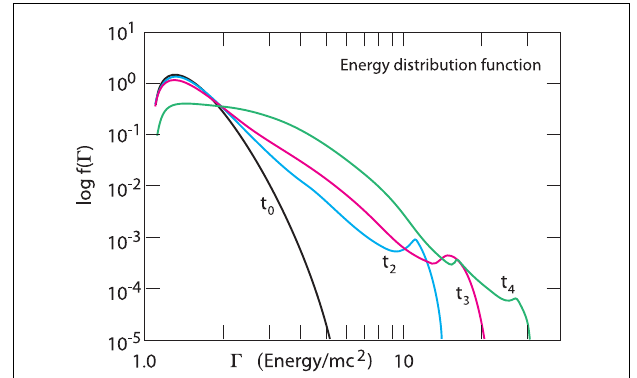
FIGURE 15 | Evolution of a high energy tail on the initial particle distribution function in pair plasma simulations of three-dimensional reconnection [schematized, simulation data after 42]. Three of four equally space consecutive simulation time snapshots of the relativistic distribution function f ((cid:7)) are shown. The black distribution at time t 0 is the relativistic Jüttner equilibrium distribution. The gradual generation of a high energy tail by interaction of the charged particles with the reconnection electric field is seen during the evolution of the distribution from time t 0 to t 4 . The final distribution (not shown) at time when the particles reach the end of the box has evolved up to (cid:7) ∼ 80, indicating strong particle acceleration. The distributions exhibit an intermediate region of quasi-power law f ((cid:7)) ∼ (cid:7) − s , with index 3 < s (cid:2) 4, followed by a steep high energy cut-off. Note the formation of a (weak though statistically significant) high energy